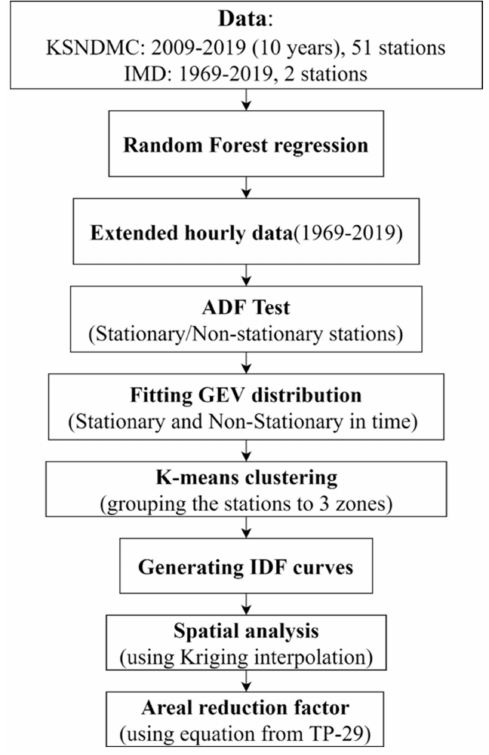
Figure 2. Schematic diagram showing the primary tasks of this